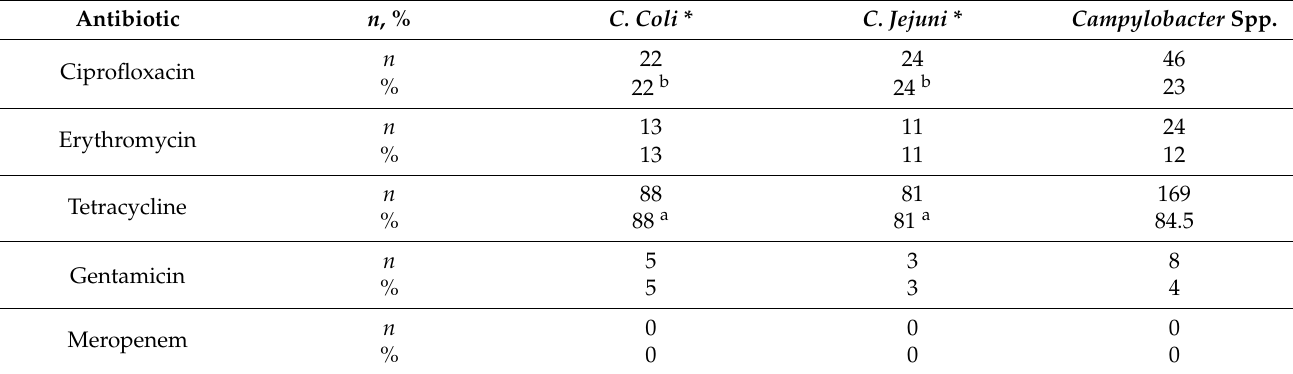
Table 3. Antimicrobial resistance of Campylobacter coli , Campylobacter jejuni , and Campylobacter spp. Antibiotic